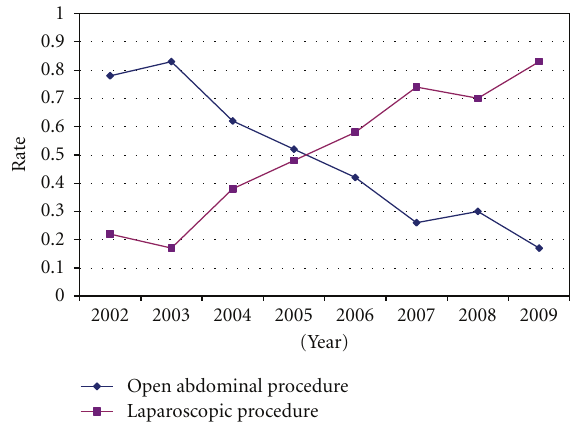
Figure 1: Rate of open abdominal and laparoscopic hysterectomy in women with endometrial cancer,